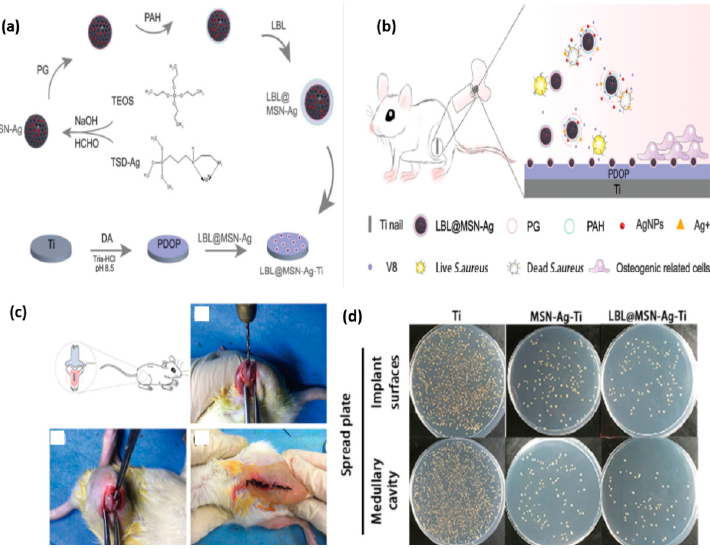
Figure 9. The enzyme ‐ sensitive nanosystem. ( a ) The illustration of the mechanism for obtaining LBL@MSN ‐ Ag ‐ Ti sub ‐ strates. ( b ) Illustration of infection cure and bone tissue growth. ( c ) The osteogenic response after implantation in infected femurs in rats. ( d ) The antibacterial activity on the different implant surfaces after one week of implantation. Reproduced from [110], with permission from © The Royal Society of Chemistry 2020. Other authors engineered an enzyme ‐ responsive nanoplatform for the theranostics of breast cancer by using self ‐ assembled nanoparticles of an N ‐ (2 ‐ hydroxypropyl methyl) acrylamide copolymer ‐ gadolinium ‐ paclitaxel ‐ Cyanine5.5 conjugate. The enzymatic trig ‐ ger was the tetrapeptide GFLG which facilitated the disruption of the high ‐ molecular weight conjugate in low ‐ molecular weight cathepsin B products, releasing the anticancer drug in the tumor [126]. Adenosine triphosphate ‐ coated (ATC) enzyme ‐ sensitive silver nanoparticles are especially engaging because of their astounding stability in a typical physiological climate and controllable suppression of liver carcinoma cells in humans [111]. New insights for developing an intelligent drug release nanoplatform for controlla ‐ ble glioblastoma therapy were described. Activatable low ‐ molecular weight protamine— poly(ethylene glycol) ‐ poly( ε‐ caprolactone)—nanoparticles (ALMWP ‐ NP) demonstrated remarkably superior protease ‐ dependent glioma controllable reactions [112]. The layer ‐ by ‐ layer technique was utilized for improving the design of carrier systems. A nanoplat ‐ form formed from poly(2 ‐ oxazoline) ‐ based materials was engineered to initiate thrombo ‐ lysis via a urokinase plasminogen activator [113]. 2.4. Dual and Multi ‐ Responsive Nanomaterials A step forward for biomedical applications is attained when the smart nanomaterials are simultaneously sensitive to more stimuli. The nanomaterials which are sensitive to a few sorts of stimuli are the key for expanding the efficacy of drug delivery and for sup ‐ porting the diagnosis by monitoring a few physiological changes at once. The development of nanomaterials with both diagnostic and therapeutic properties is the most powerful technological frontier for moving forward to nanotheranostics. The demand for these technologies is based on the advantage of multiple functions such as